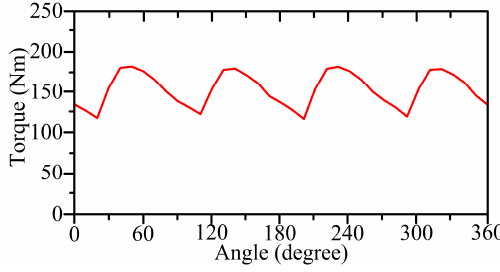
Figure 14. Torque waveforms under the unipolar conduction scheme.